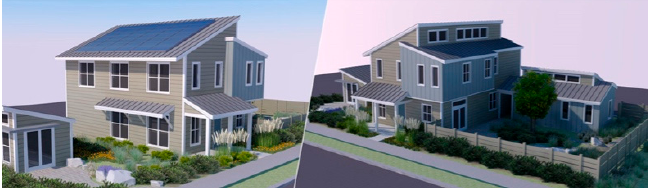
Figure 2. The architecture of the Honda Smart Home US [45].